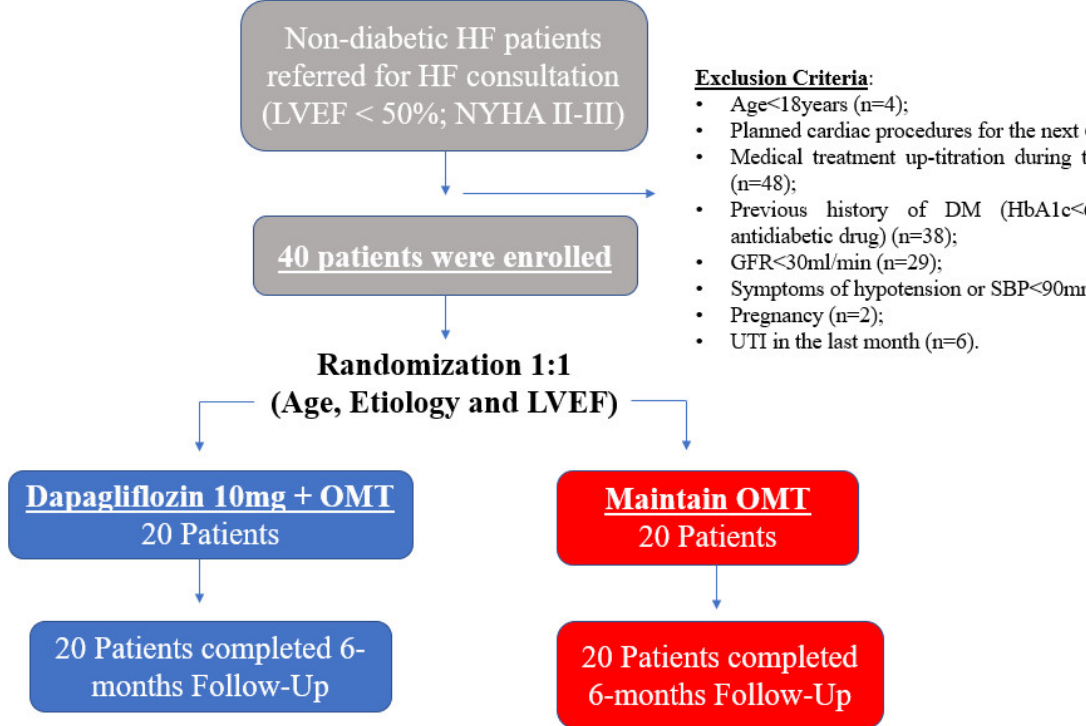
Figure 1. Study design and population selection.